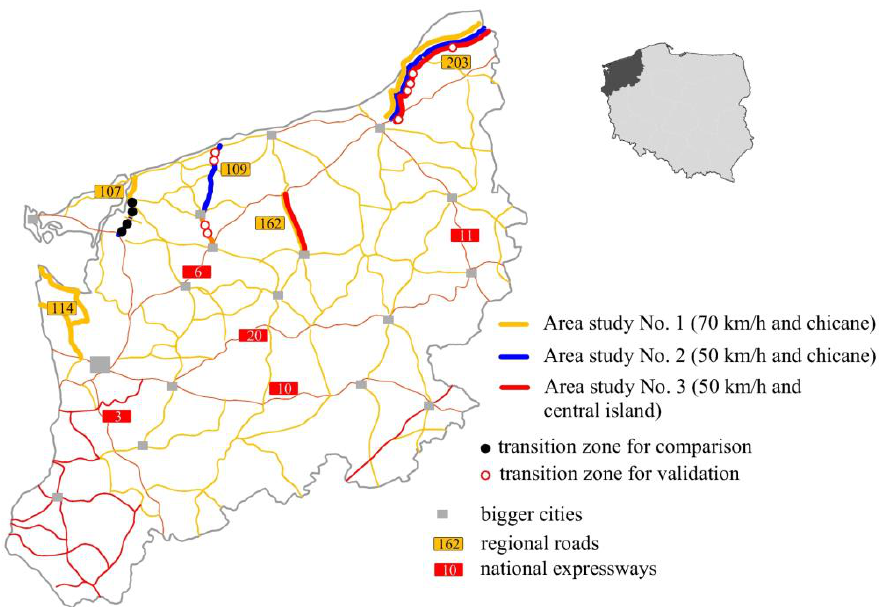
Figure 4. Map of the study area showing the locations of transition zones on regional roads in NW Poland. Source: own work of the authors.